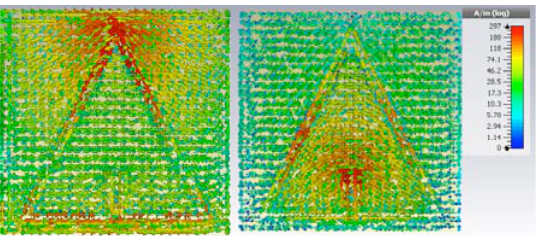
Fig .8. Surface current distribution of the dual band AMC structure at (a) 2.45GHz, (b) 5.20GHz.